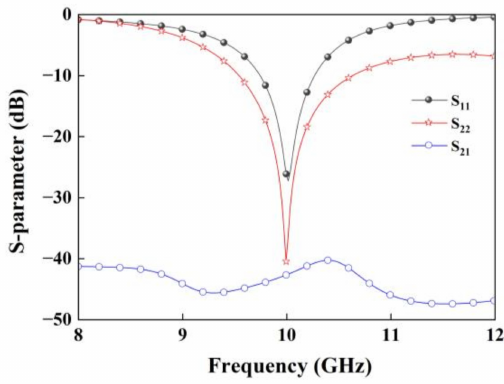
Figure 3. Numerically simulated S-parameters of the dual-LP patch